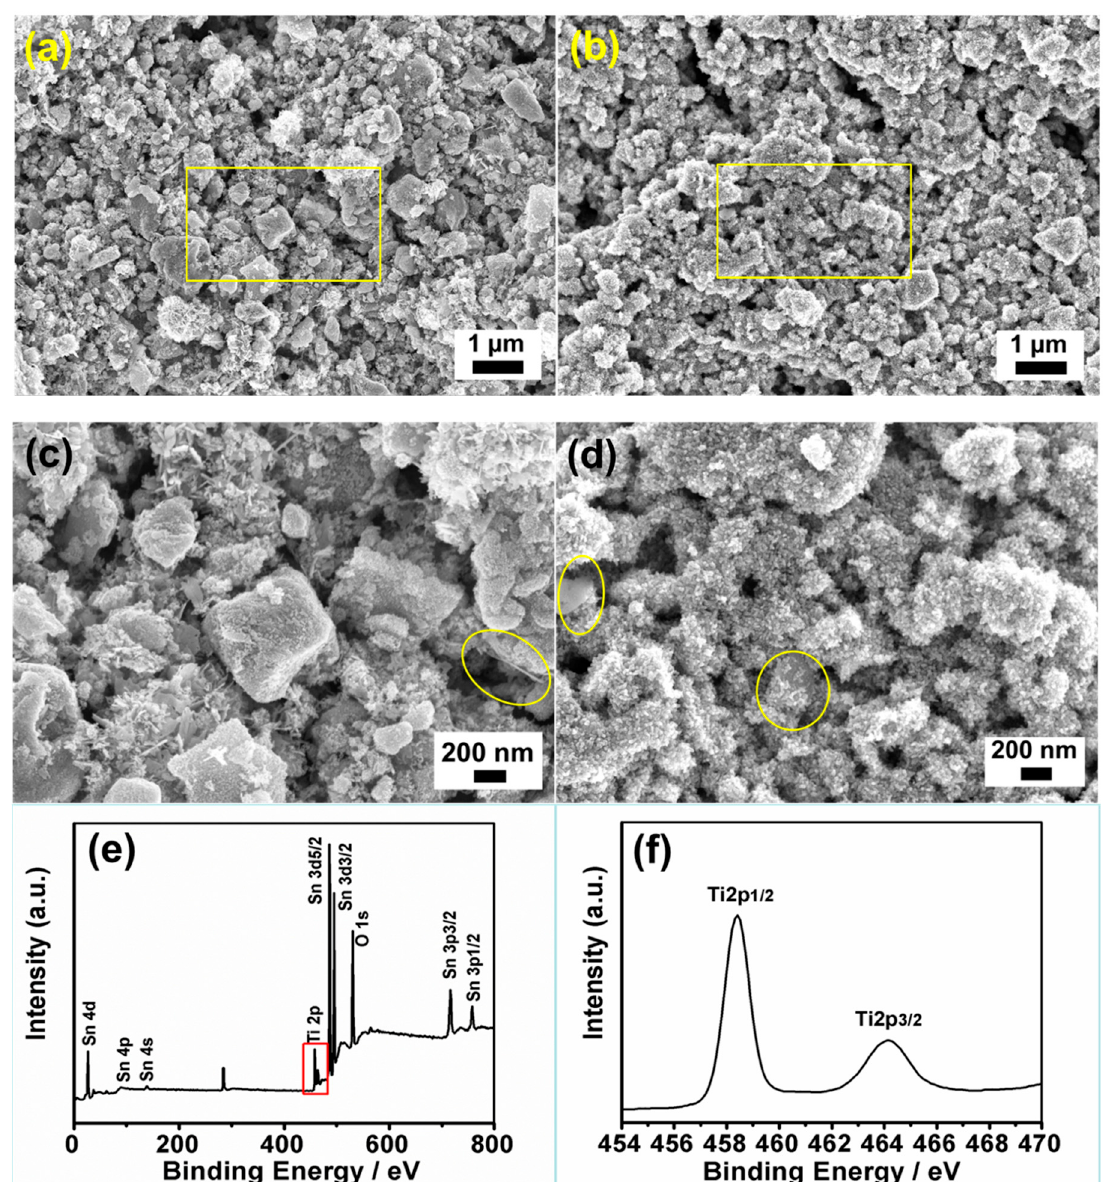
Figure 3. SEM images of SnO 2 NA/NS hybrid films ( a , c ) before and ( b , d ) after TiCl 4 treatment with different modifications; XPS spectra of ( e ) survey and ( f ) Ti 2p peaks.